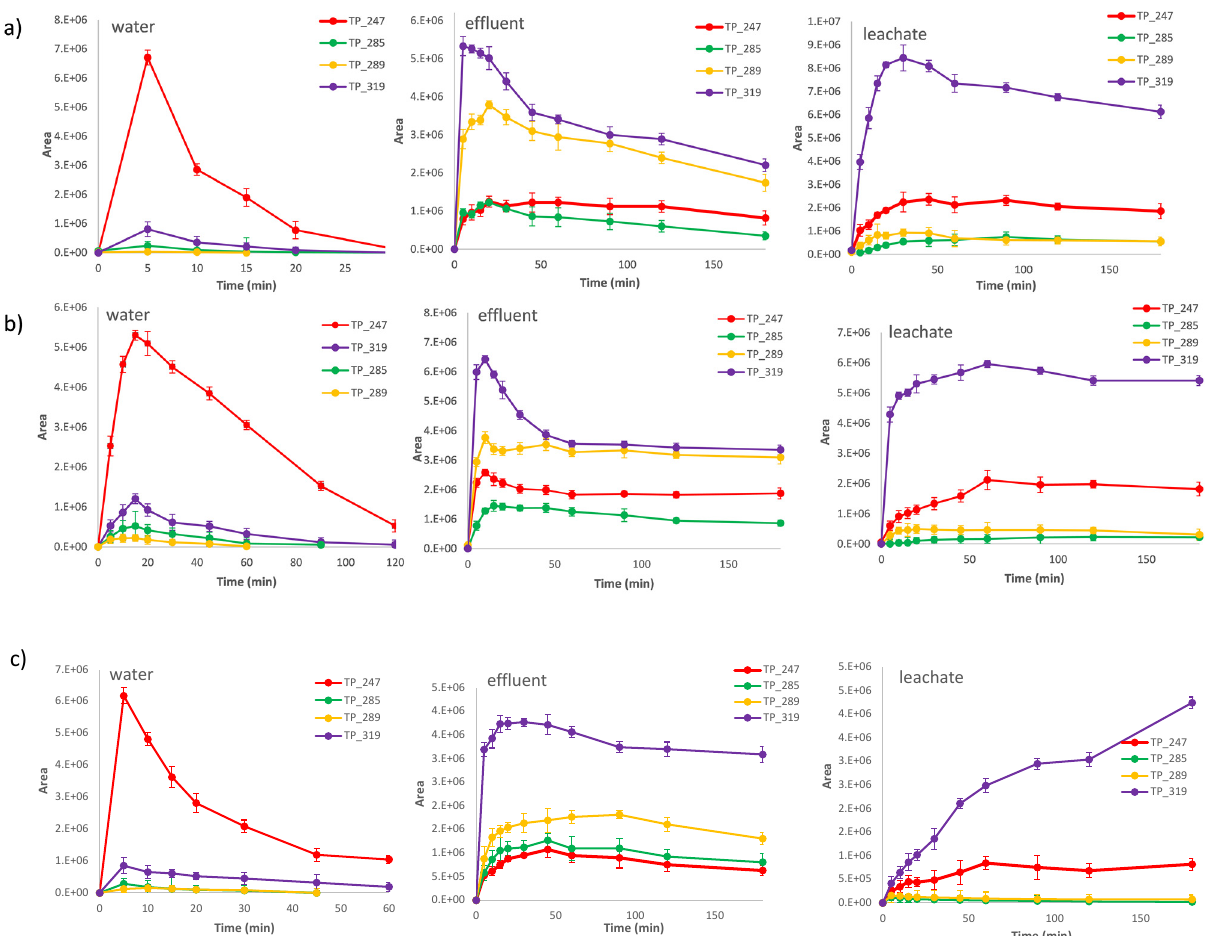
Figure 8. Evolution profile of the basic TPs of abacavir in three different matrices during heterogenous and homogeneous photocatalysis ( a ) UV/TiO 2 , ( b ) UV/MOF/S 2 O 82 − , and ( c ) UV/Fe 2+ /S 2 O 82 − C 0 = 10 mg/L, C catalyst = 100 mg/L, CFe 2+ =1 mg/L, C oxidant = 15 mg/L.